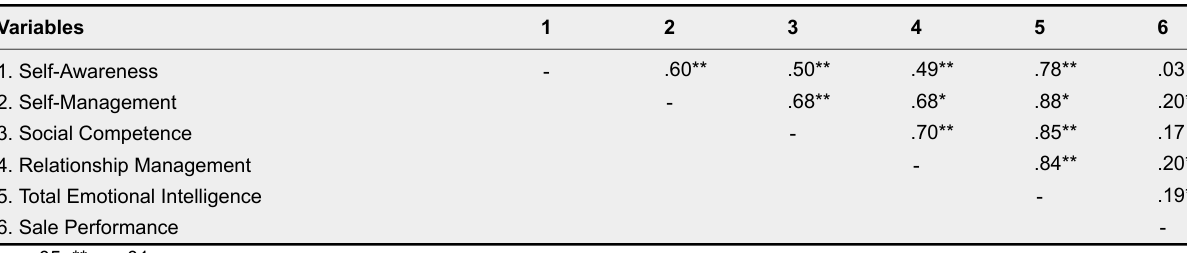
Correlations Between the Main Study Variables